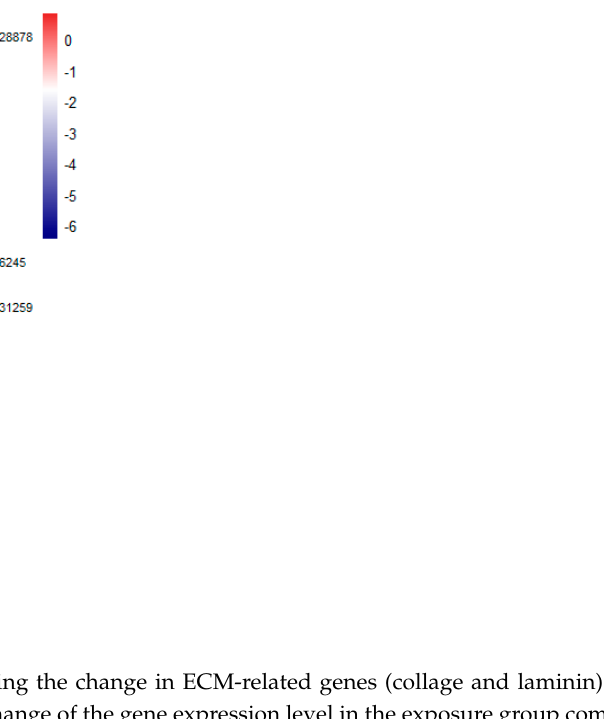
Figure 5. KEGG pathway enrichment analysis of differentially expressed genes between the control and noise exposure groups. The x -axis represents the enrichment factor for each of the differentially expressed genes in each pathway. The y -axis shows the name of the enriched pathway. The size of each node represents the number of enriched genes in that pathway, and the p.adjust values are indicated by changing colors, moving from red to blue.